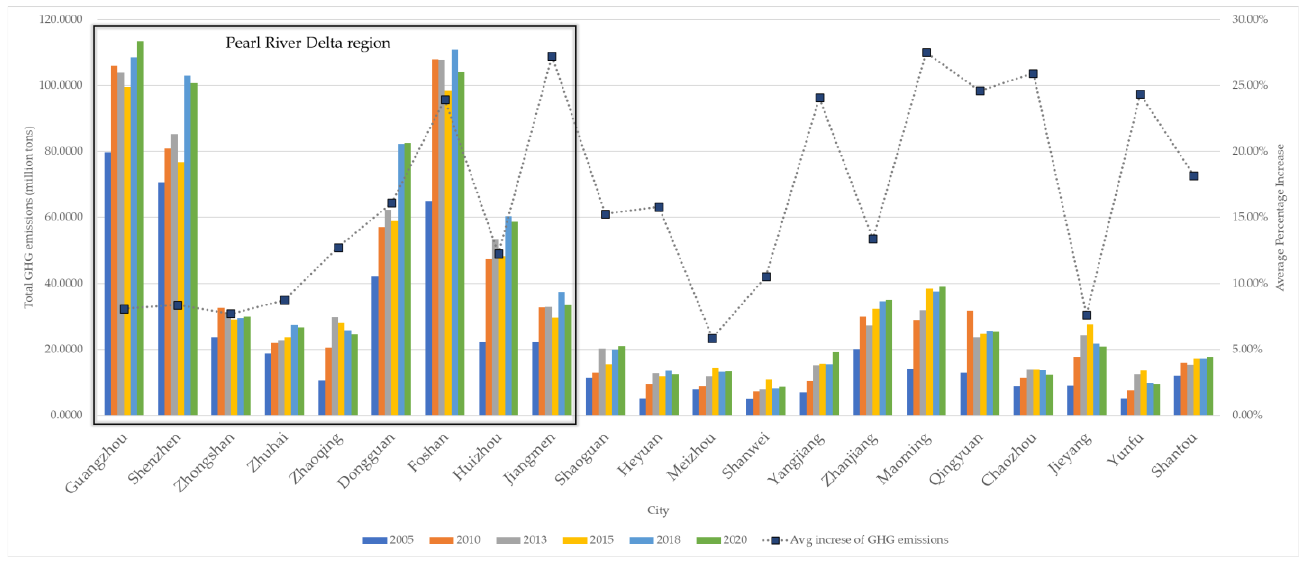
Figure 3. Temporal trends of total carbon emissions in cities of Guangdong.